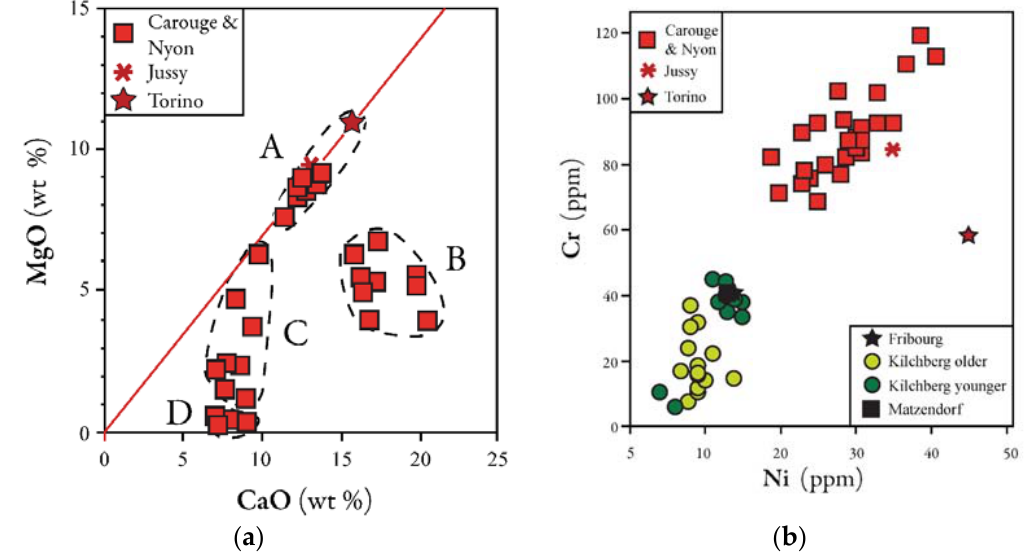
Figure 18. Body (bulk) compositions. ( a ) MgO-CaO binary diagram: the Western Swiss (Carouge & Nyon) CaO- & MgO-rich samples, including one each from France (Jussy) and Italy (Torino), group in four distinct areas; ( b ) Differentiation of the Eastern (Fribourg, Kilchberg, Matzendorf) and Western Swiss CaO-rich samples with the C-Ni binary plot.